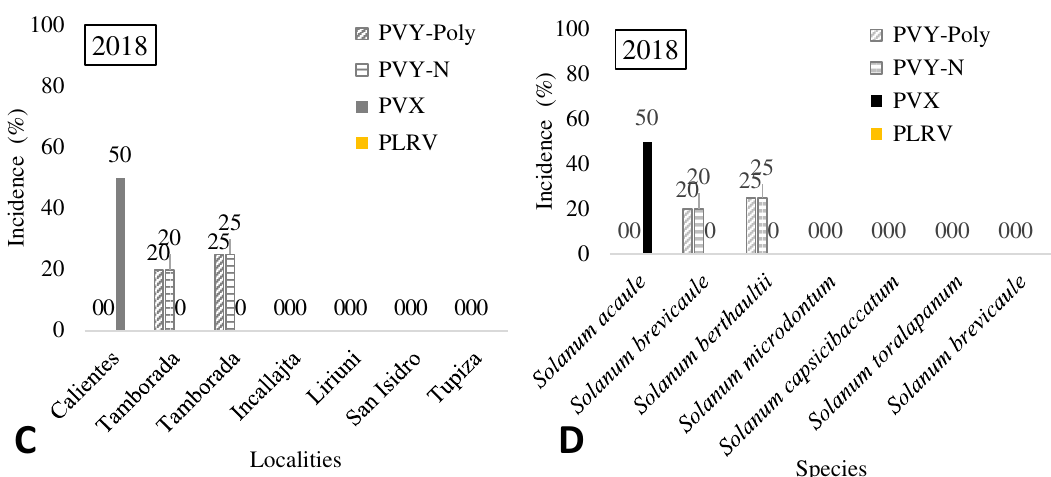
Figure 4. Viruses’ incidence on potato wild relatives in the Andean region of Bolivia C: 2018, virus incidence by locality; D: 2018, virus incidence by